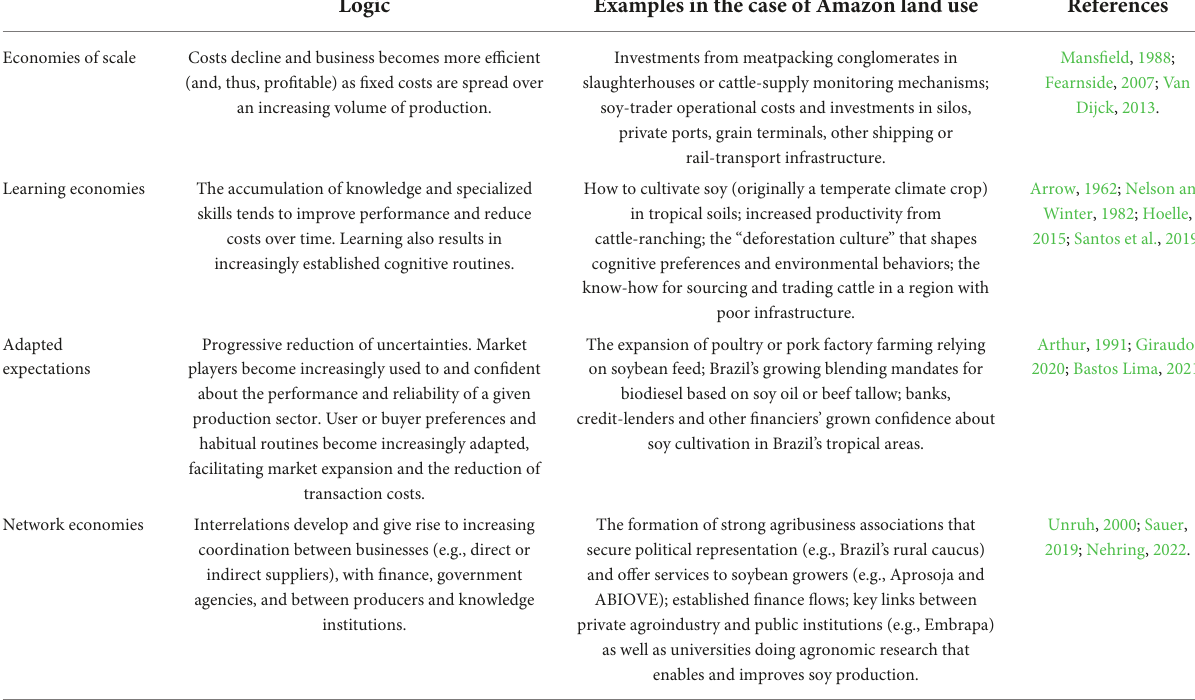
TABLE 1 Classes of increasing returns that foster